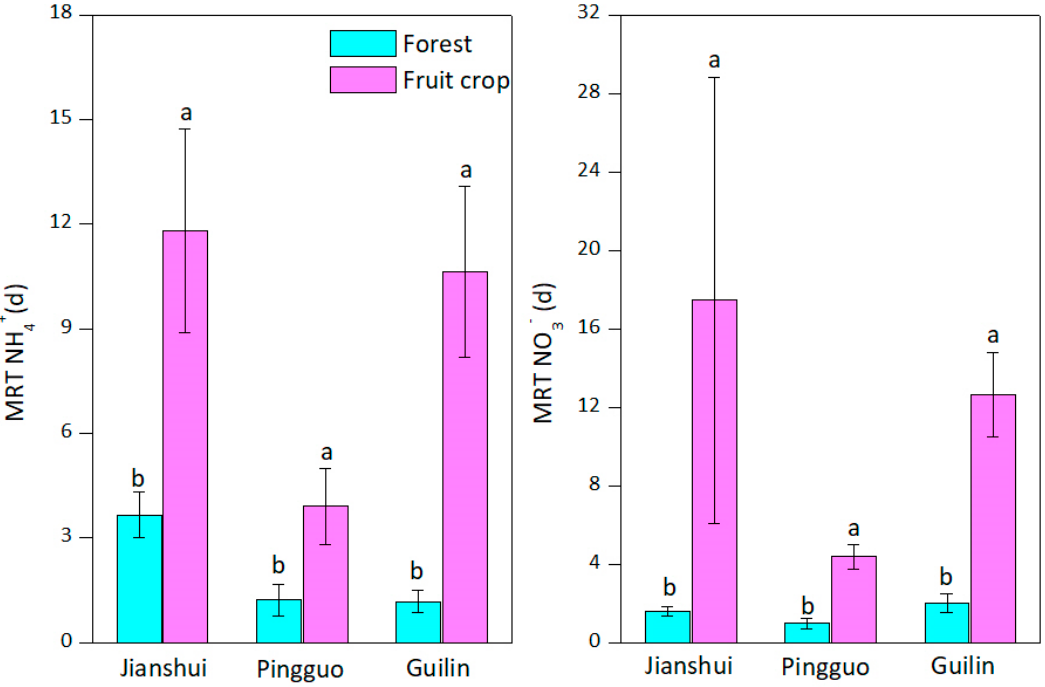
Figure 3. Mean residence time of NH 4+ (MRT NH 4+ ) and NO 32212 (MRT NO 3 − ) in soils sampled from Jianshui (forest vs. citrus), Pingguo (forest vs. pitaya), and Guilin (forest vs. Shatangju) regions. Different letters for MRT NH 4+ and MRT NO 3 − indicate significant differences ( p < 0.05) between forest and fruit crop plantation in the same region.